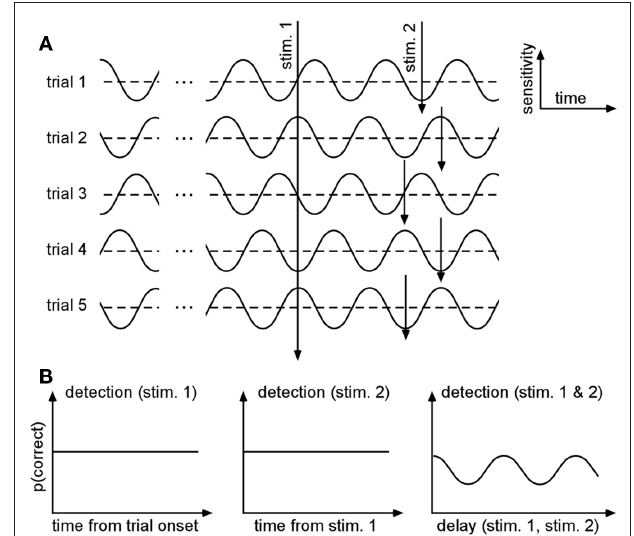
Figure 1 | Double-detection functions can reveal periodicities even when the phase varies across trials. (A) Protocol. Let us assume that the probability of detecting a stimulus (i.e., the system’s sensitivity) fluctuates periodically along with the phase of an ongoing oscillatory process. By definition, this process bears no relation with the timing of each trial, and thus the phase will differ on each trial. On successive trials, not one but two stimuli are presented, with a variable delay between them. (B) Expected results. Because the phase of the oscillatory process at the moment of stimulus presentation is fully unpredictable, the average probability of detecting each stimulus as a function of time (using an absolute reference, such as the trial onset) will be constant (left). The probability of detecting the second stimulus will also be independent of the time elapsed since the first one (middle). However, the probability of detecting both stimuli (albeit smaller) will oscillate as a function of the delay between them, and the period of this oscillation will be equal to the period of the original ongoing oscillatory process (adapted from